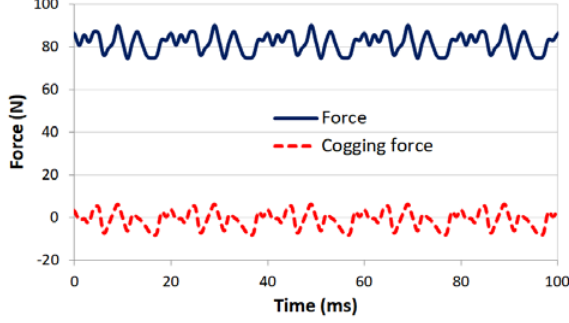
Figure 11. Electromagnetic force along the moving direction. Table 3. Performance comparison at different translator velocities.